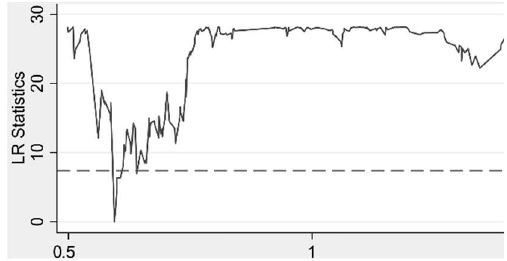
Figure 2. First Threshold.